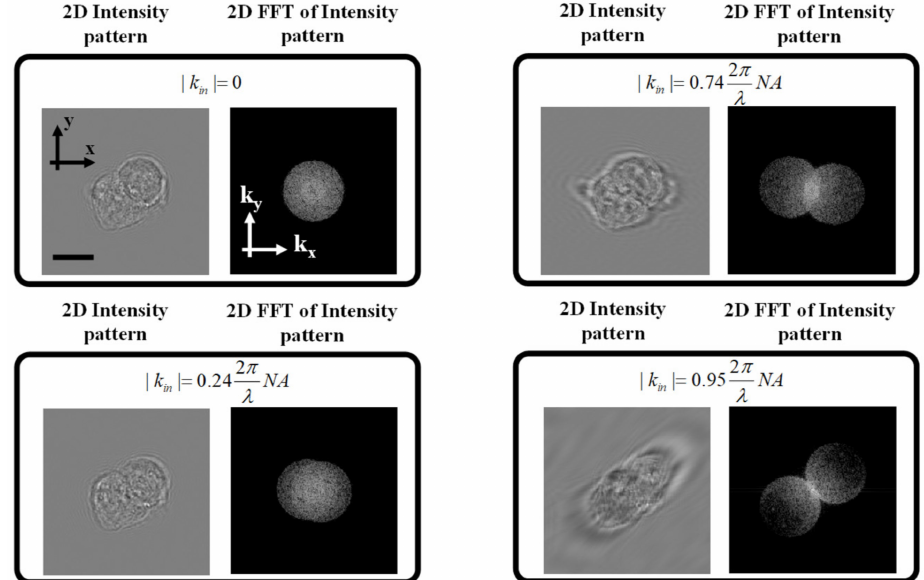
Figure 1. Intensity images and their 2D Fourier transforms for on-axis and off-axis configurations with different illumination angles. As can be seen from the figures, as the incident illumination vector k in approaches the numerical aperture of the objective lens, the 2 cross terms can be decoupled, and the principal term can be retrieved. Scale bar = 8 µ